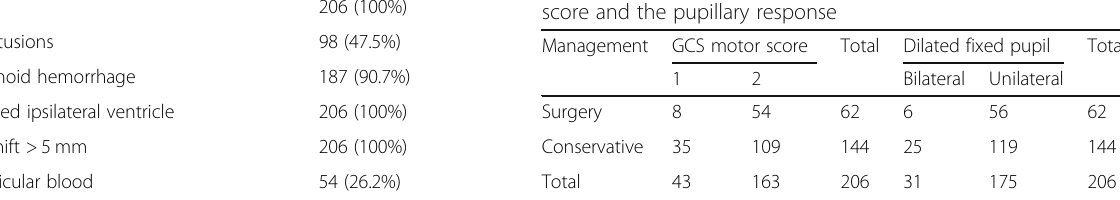
Table 2 The findings in the initial head CT scan Head CT scan findings